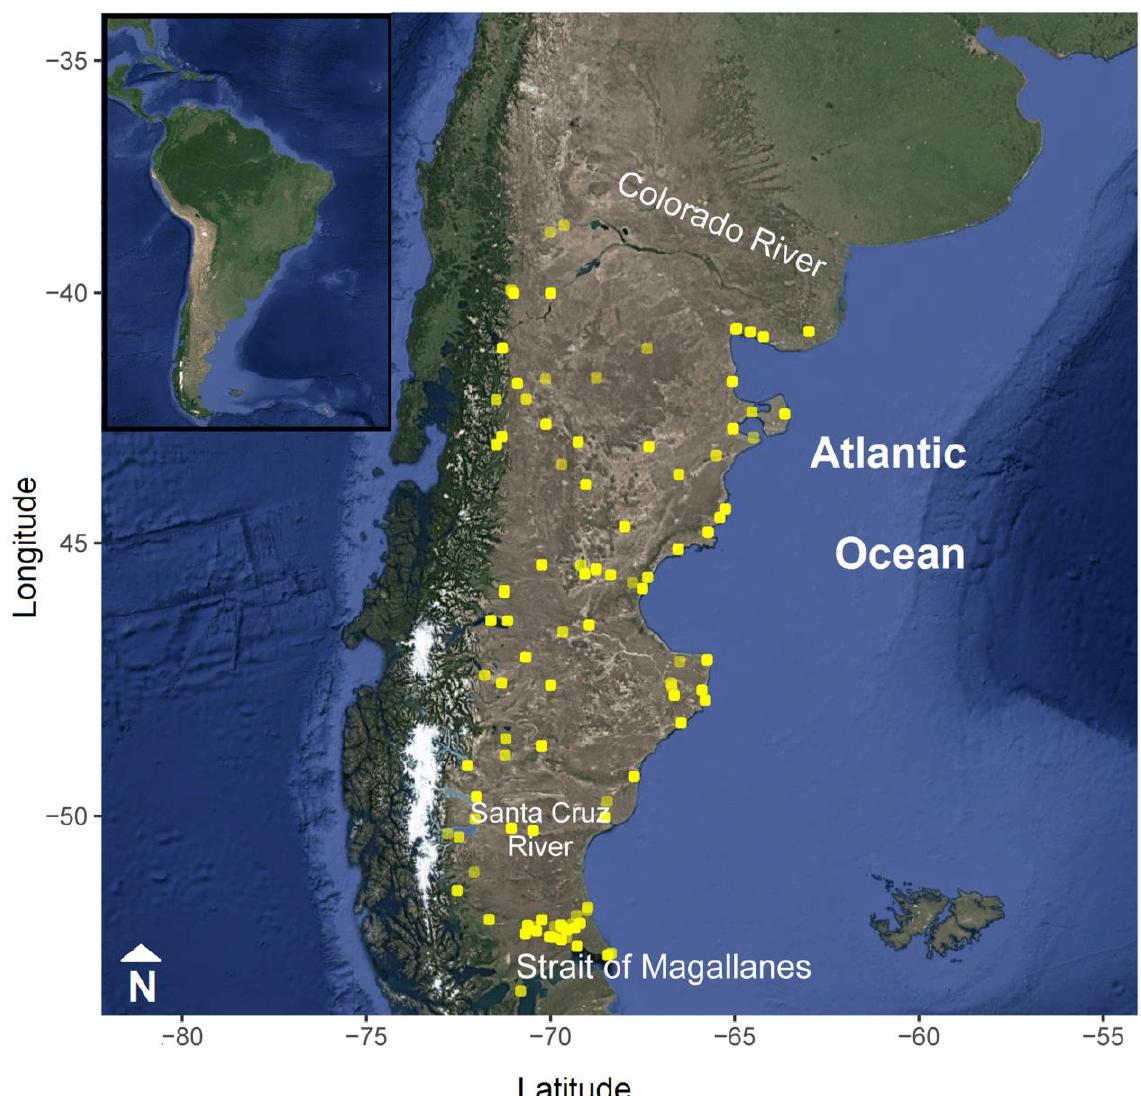
Figure 2. Distribution of projectile point samples across Patagonia. Figure obtained by ggmap 3.0 package (R developed core team